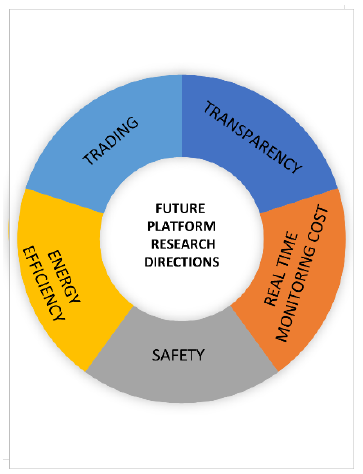
Figure 2. Flowchart of energy management platform architecture.